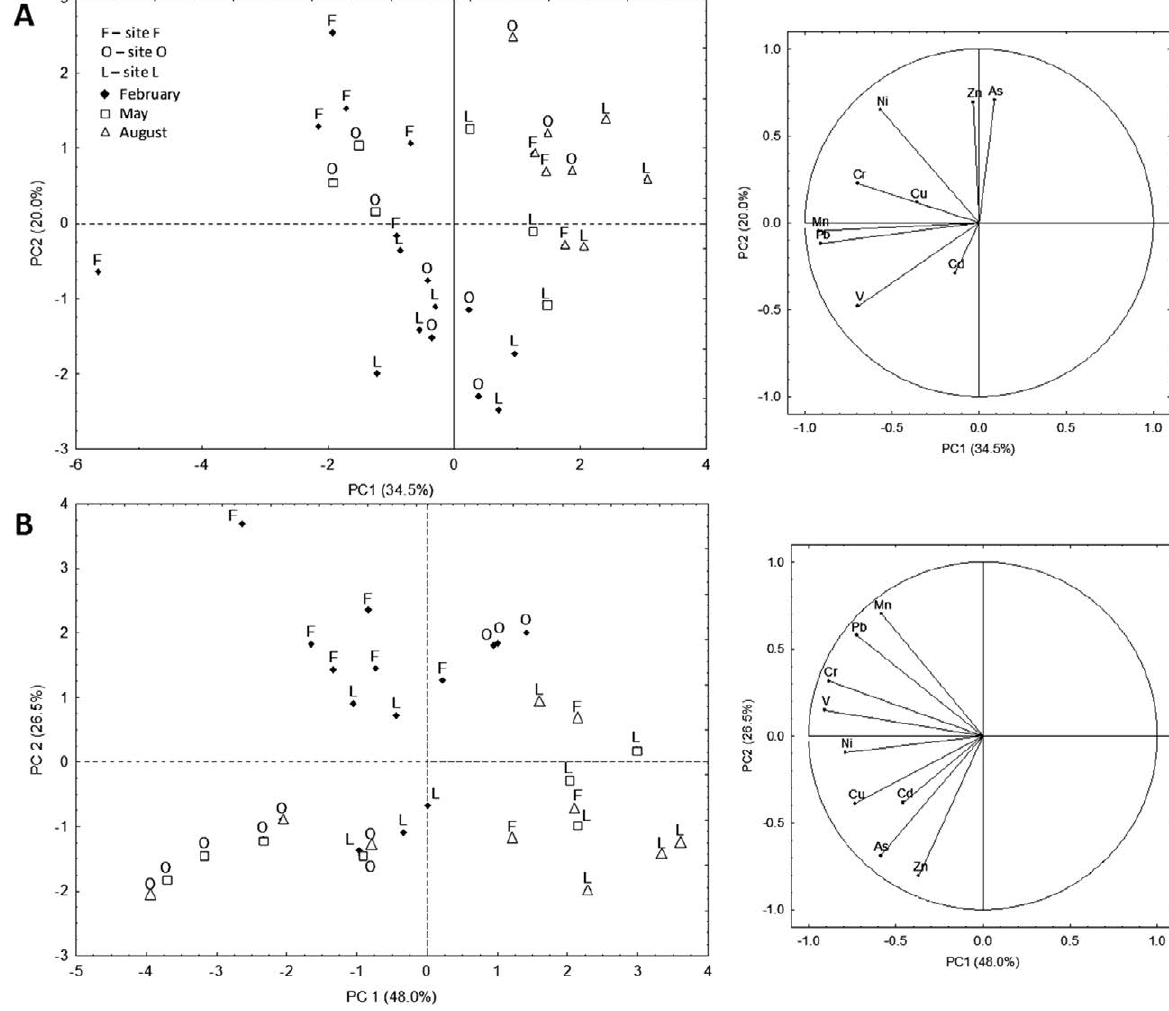
Fig. 4. – Illustration of the principal component analysis (PCA) based on element (Zn, As, Cu, Mn, Ni, V, Cr, Pb and Cd) concentrations of digestive gland (A) and remaining tissues (B) of the clam Ruditapes decussatus from sites F, O and L at four sampling dates. For digestive gland (PC1=34.5% and PC2=20.0%), Mn, Pb and Cr are associated with PC1, and As is associated with PC2 (factor coordinates >|0.7|). For remaining tissues (PC1=48.0% and PC2=26.5%), V, Cr, Ni, Cu and Pb are associated with PC1, and Zn and Mn are associated with PC2 (factor coordinates